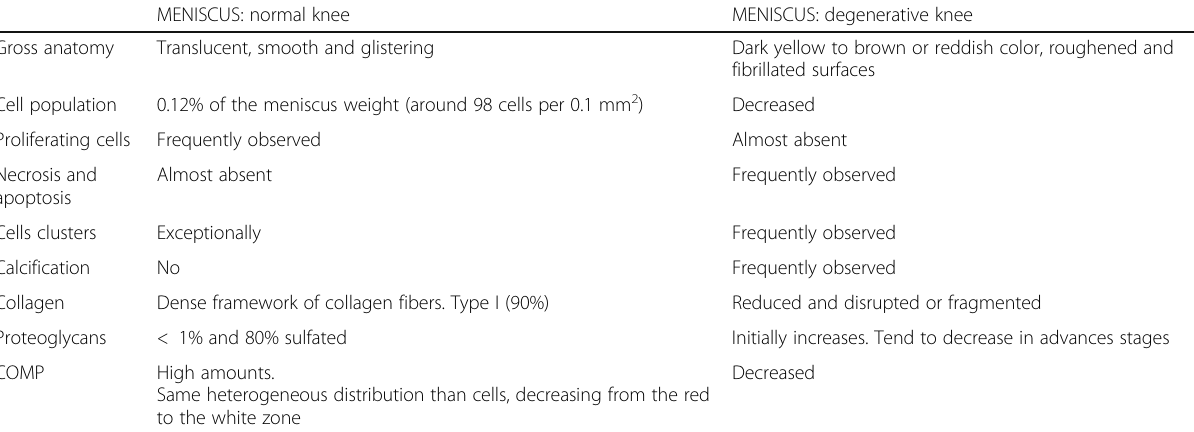
Table 1 Meniscal differences between the normal and the degenerative knee MENISCUS: normal knee MENISCUS: degenerative knee